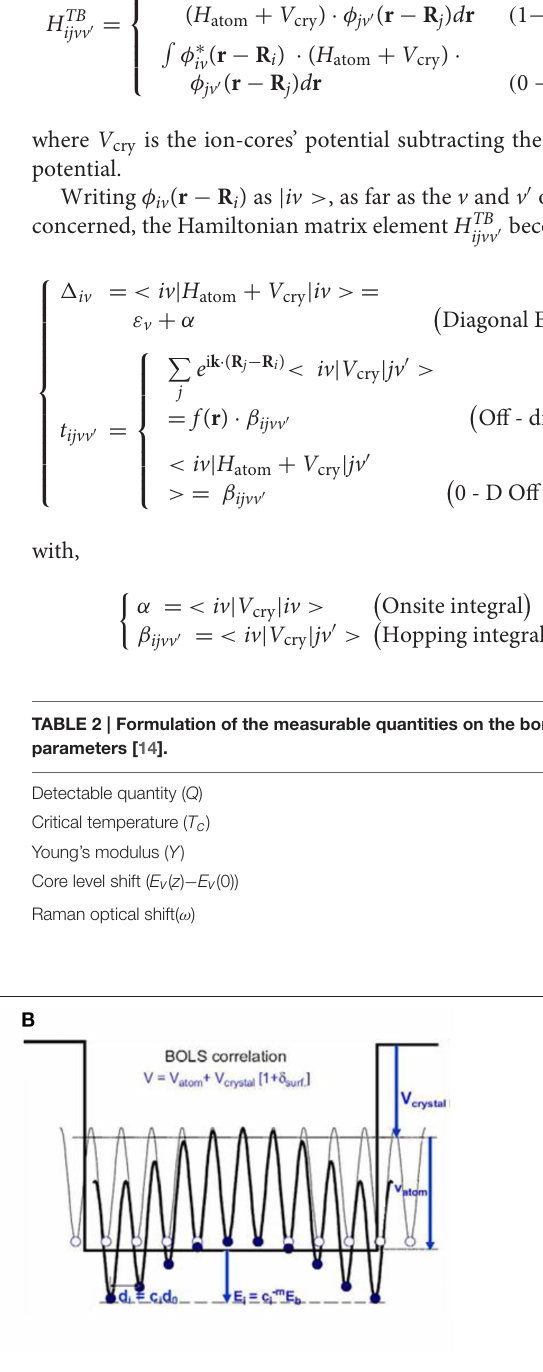
Frontiers in Physics |